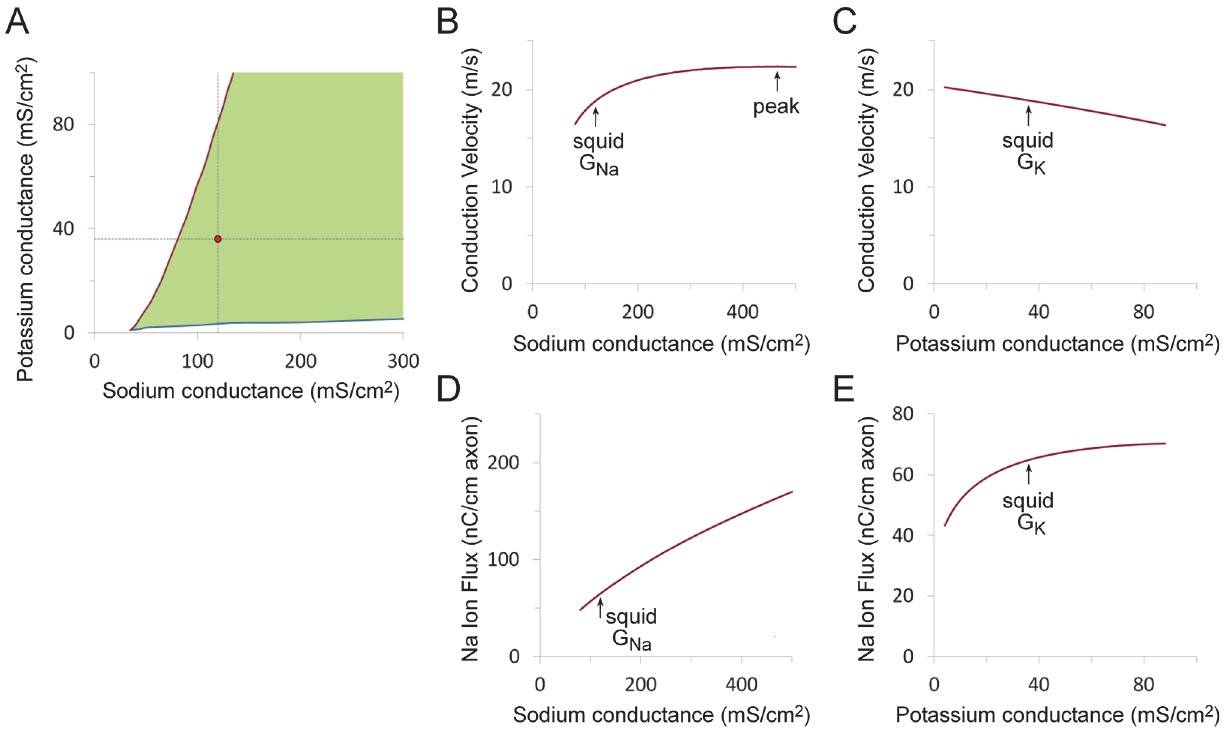
Fig 2. Effect of variations in sodium and potassium channel expression on physiological function. A. Region of sodium and potassium conductance parameter space that supports action potential conduction up to 26°C (filled green area). Upper (red) line corresponds to boundary above which action potential conduction fails to propagate. Lower (blue) line corresponds to boundary below which the action potential fails to repolarize. The experimentally observed combination of conductance values is marked with a red dot. B. Dependence of conduction velocity on peak sodium conductance. The sodium conductance at which conduction velocity peaks (465 mS/cm 2 ) is marked with an arrow (labeled ‘ peak ’ ), as is the experimentally observed value (120 mS/cm 2 ) (labeled ‘ squid G Na ’ ). C. Dependence of conduction velocity on peak potassium conductance. The experimentally observed value (36 mS/cm 2 ) is marked (labeled ‘ squid G K ’ ). D. Dependence of sodium ion flux during the action potential on sodium channel conductance. E. Dependence of sodium ion flux during the action potential on potassium channel conductance. For the simulations shown in panels B-E, one voltage-gated conductance was kept constant (either potassium conductance = 36 mS/cm 2 or sodium conductance = 120 mS/cm 2 ), while the other conductance was swept over the range of conductance values for which action potential conduction did not fail at 26°C. The leak conductance was kept constant (0.3 mS/cm 2 ) for all simulations. The simulation temperature was 18.5°C.